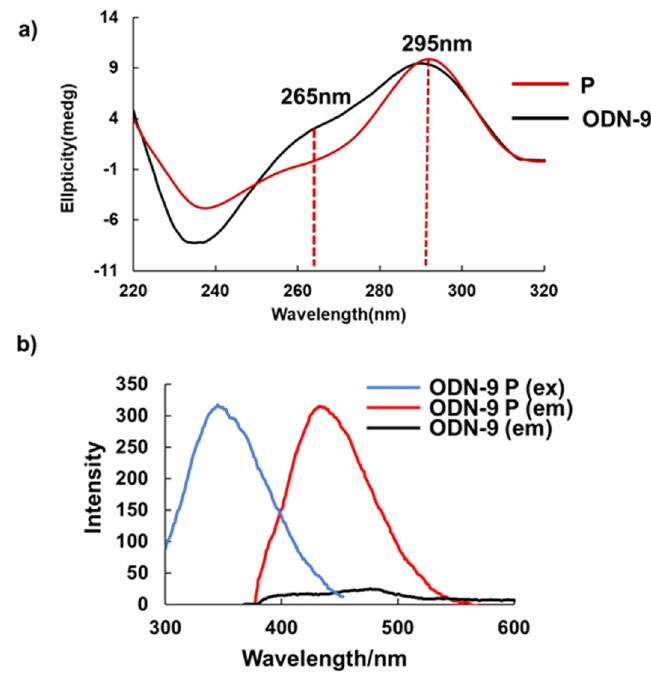
Figure 4. ( a ) CD spectrum of unreacted and click reaction product of ODN-9. ( b ) Fluorescence spectra for modified oligonucleotides. ODN-9 P (em): the emission spectrum for click reaction product of ODN-9; ODN-9 (em): emission spectrum for the ODN-9 unreacted sequence; ODN-9 P (ex), excitation spectrum (345 nm).